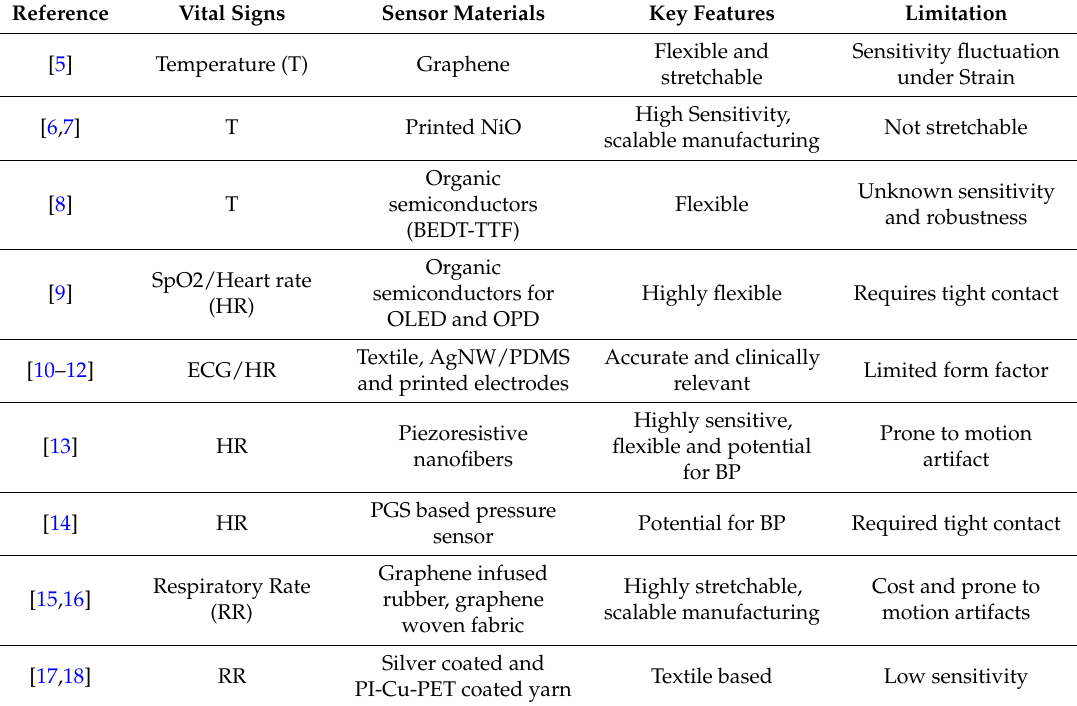
Table 1. Examples of novel wearable sensors and associated materials for vital sign